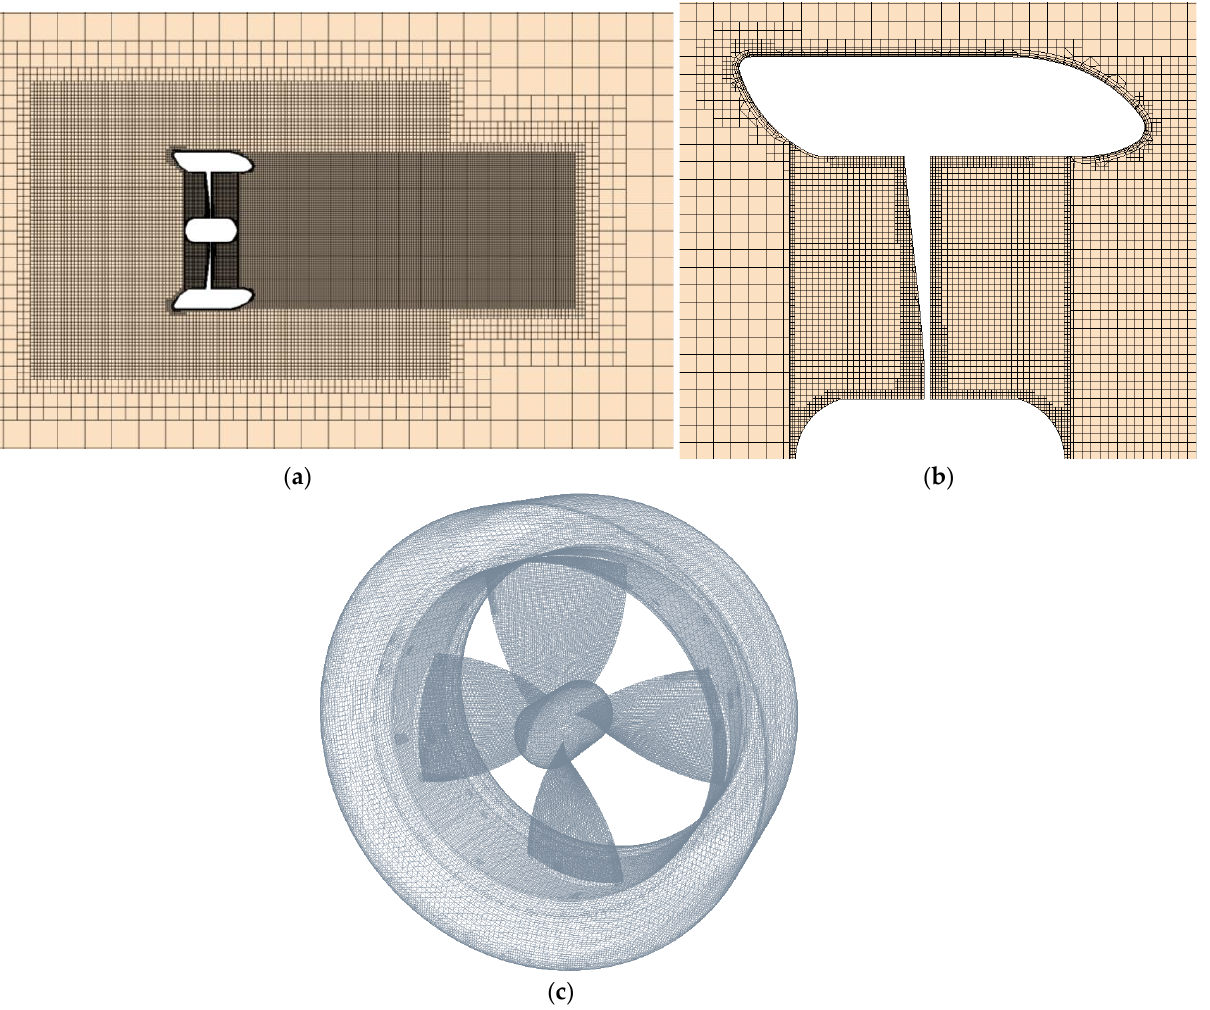
Figure 4. Grid division of computing domains: ( a ) yoz cross section of static domain; ( b ) yoz cross section of rotating domain; ( c ) RDT surface.